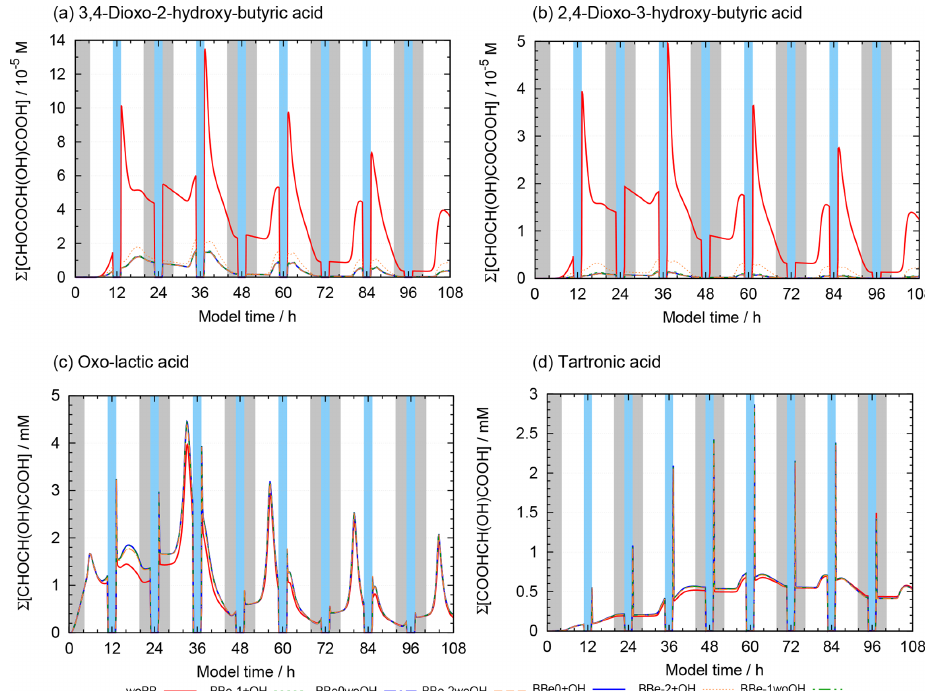
Figure 11. Accumulated concentration–time profiles of all hydration and dissociation forms of products of 2-oxo-3-hydroxy-succinaldehyde in the sensitivity runs investigating the decay of polycarbonyl compounds under urban summer conditions with eight cloud passages using the preliminary CAPRAM–GECKO-A protocol described in the text. Cloud passages shaded blue and night-time periods are shaded grey. Scenario names used in the legend are explained in Appendix